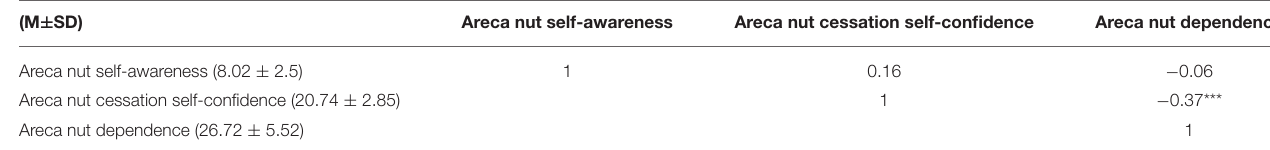
TABLE 2 | Correlation analysis among areca nut self-awareness, areca nut cessation self-confidence, and areca nut dependence ( n =